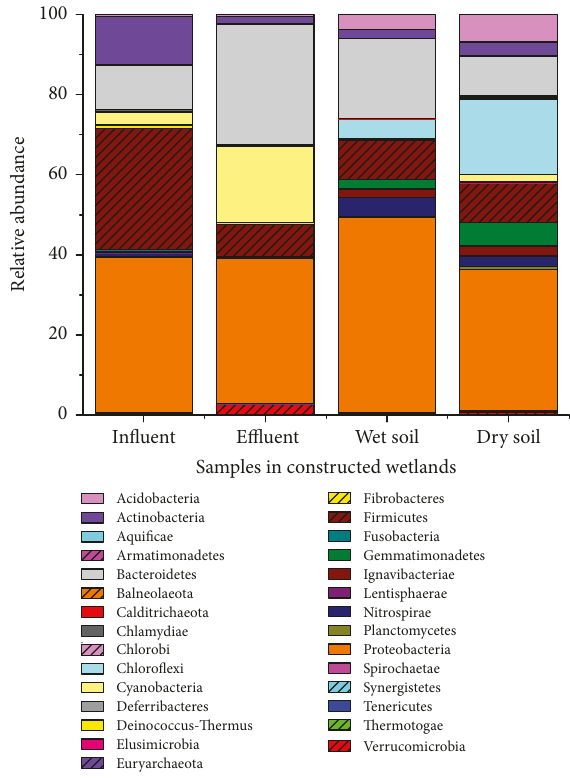
Figure 3: Bacterial relative abundance of four samples in phyla in constructed